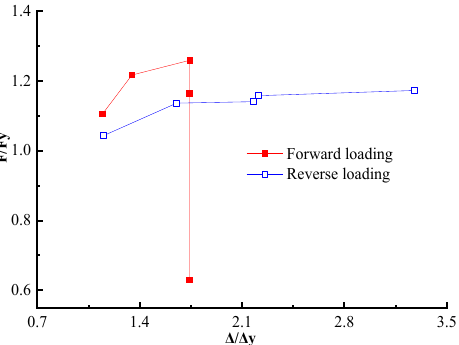
Figure 18. Change in bearing capacity after yielding for specimen 1.